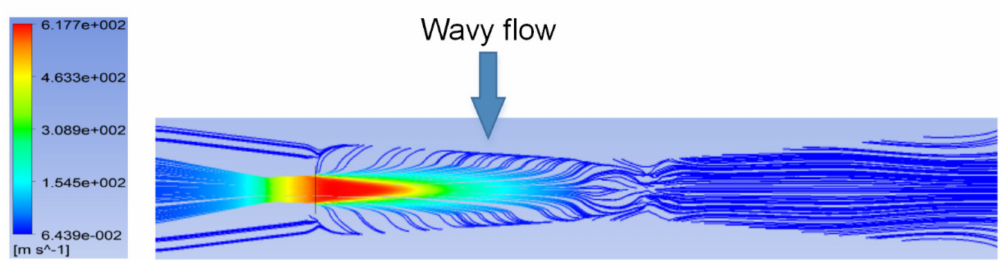
Figure 6. Steam velocity streamline in axial section for case